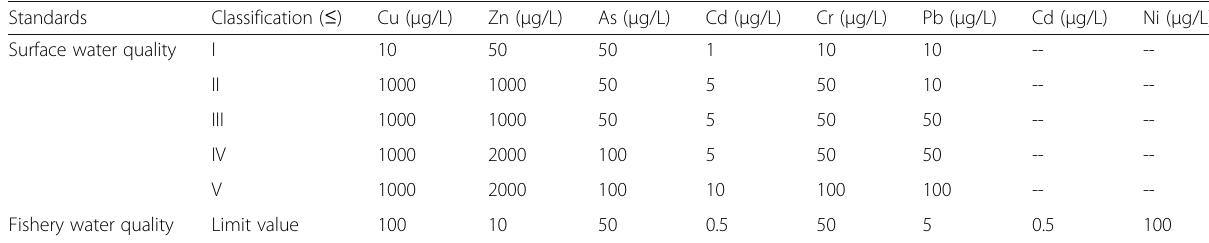
Fishery water quality